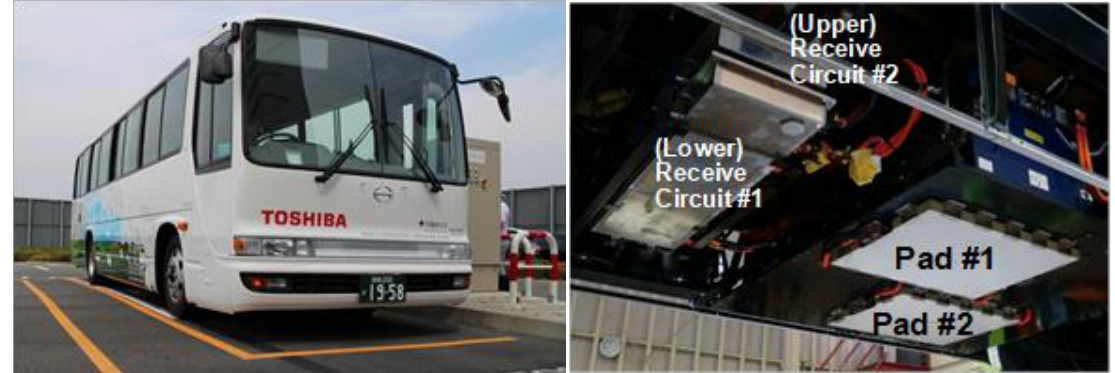
Figure 6. The Small Bus (WEB3 Advanced) and the Receive Equipment installed to the Bus.